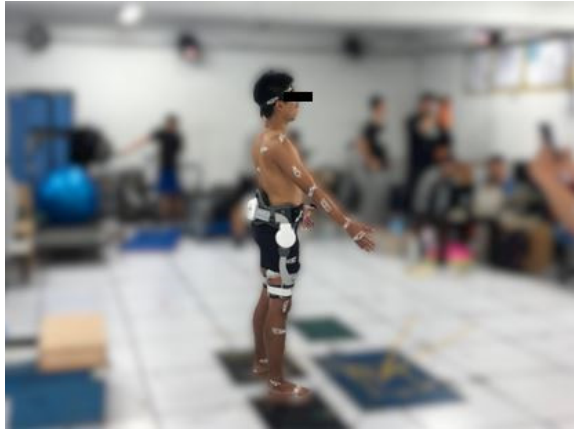
Figure 21. A subject wore the robotic exoskeleton with EMG sensors and reflectors attached to his body.